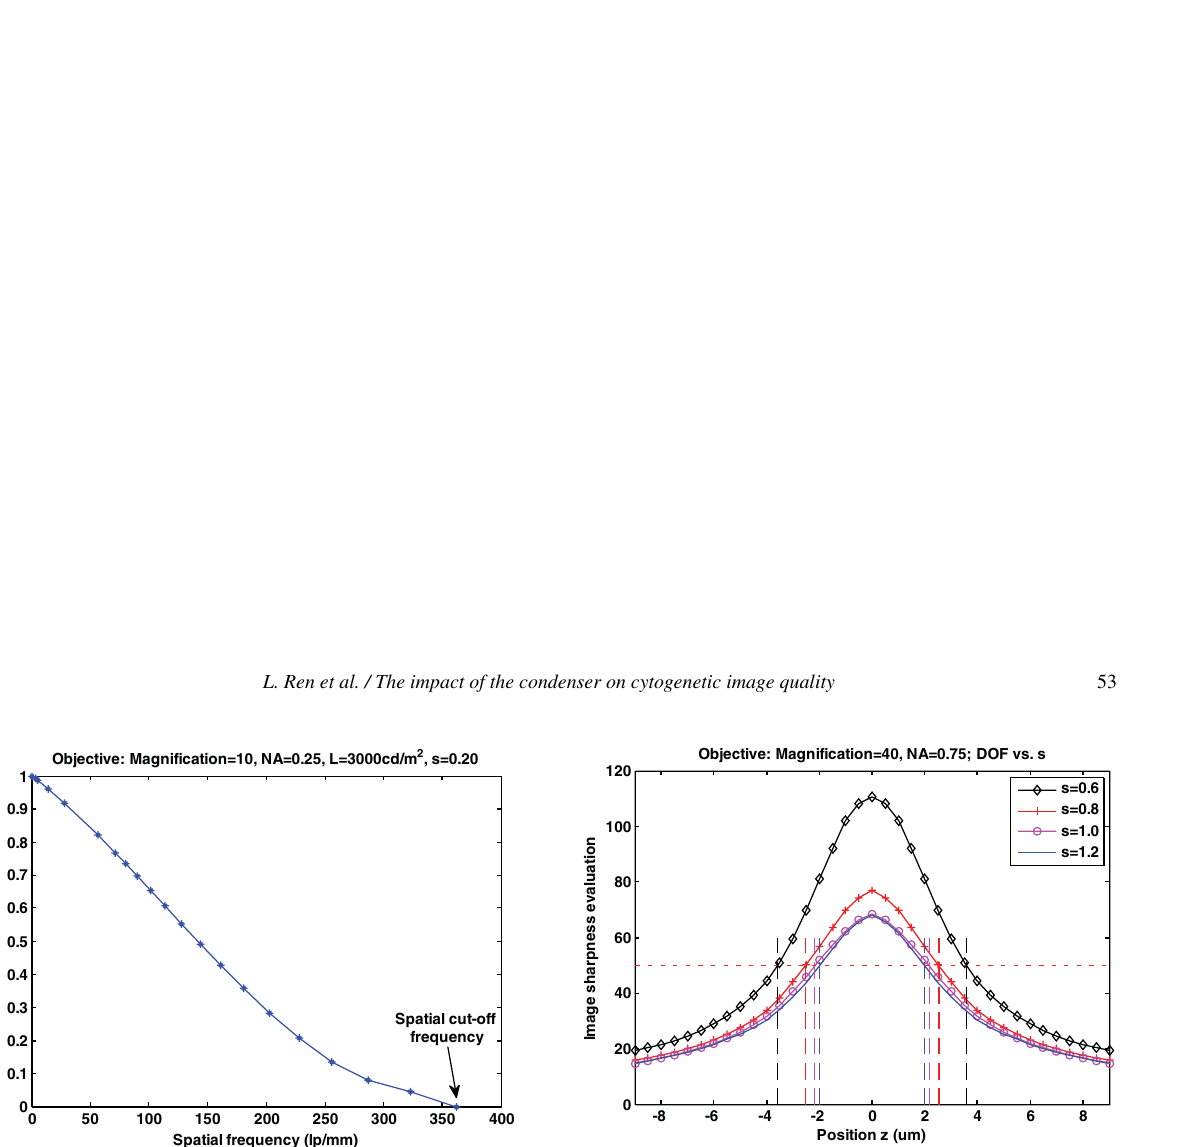
Fig. 6. The CTF curve and the corresponding spatial cut- off frequency under the condition: 10 × (dry, NA obj = 0 . 25), L=3000cd/m 2 and s =0.2.